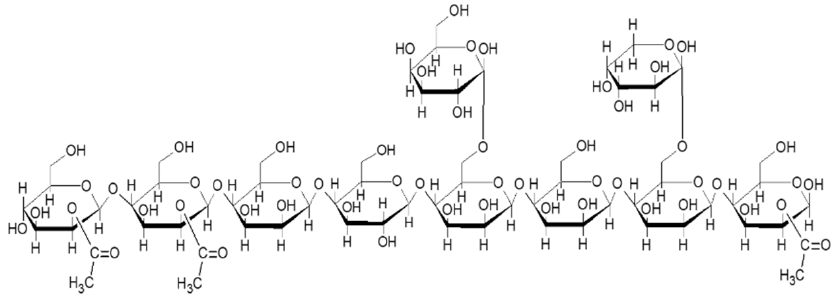
Figure 5. Chemical structure of green coffee